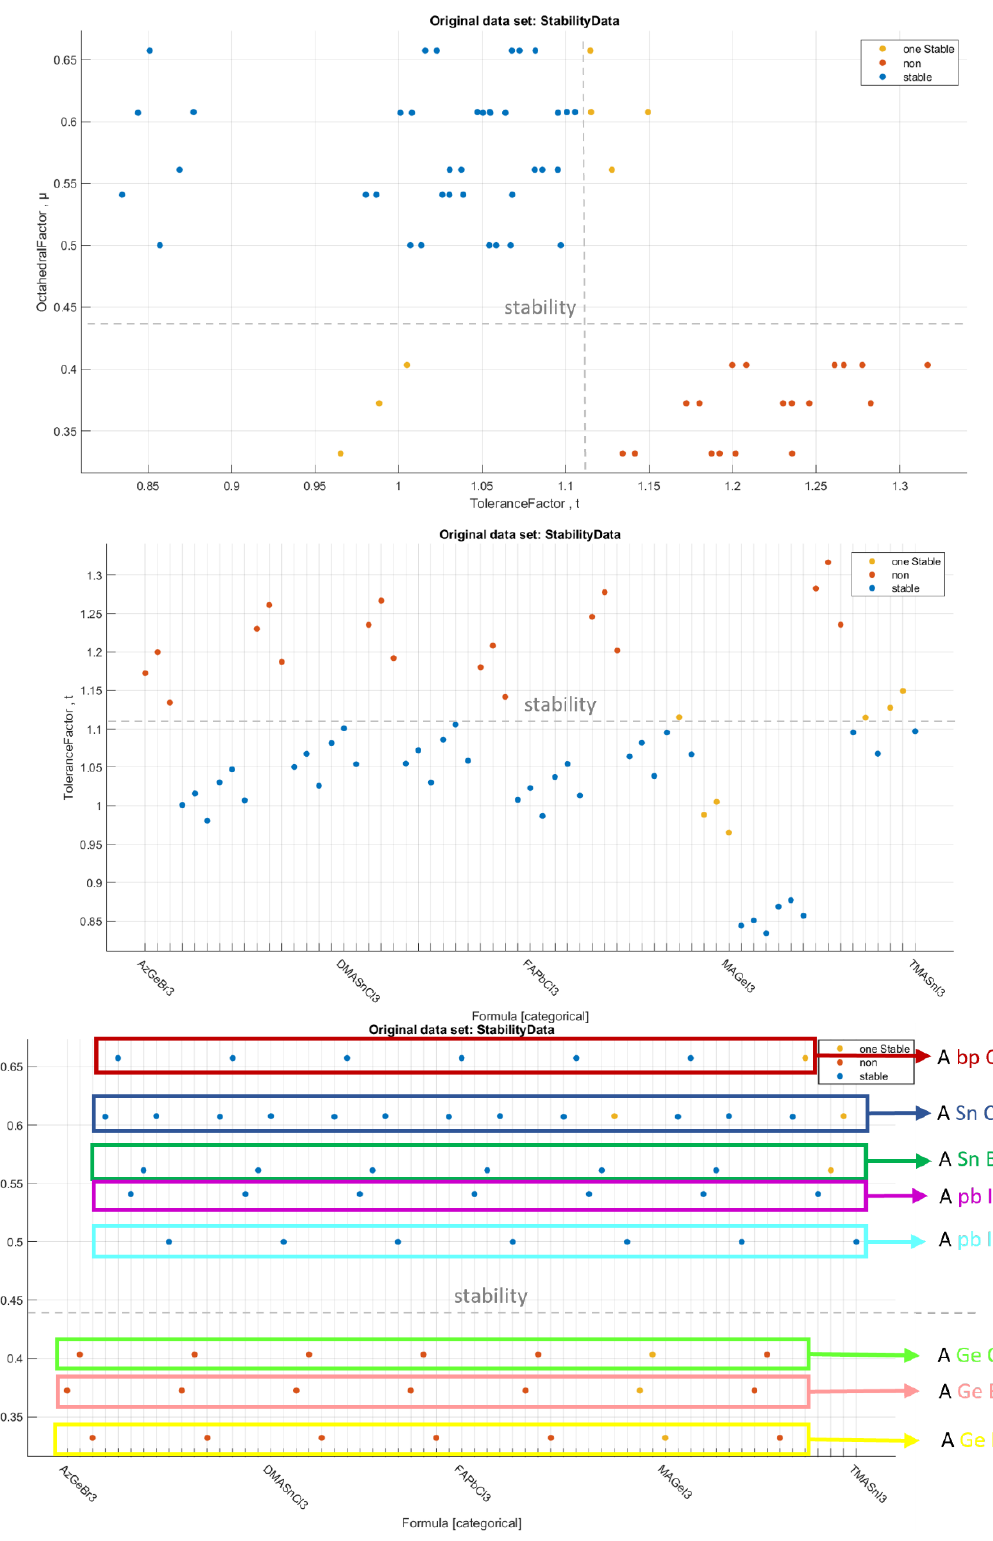
Figure 12. Stability data analysis of the perovskite compounds (ABX 3 ).